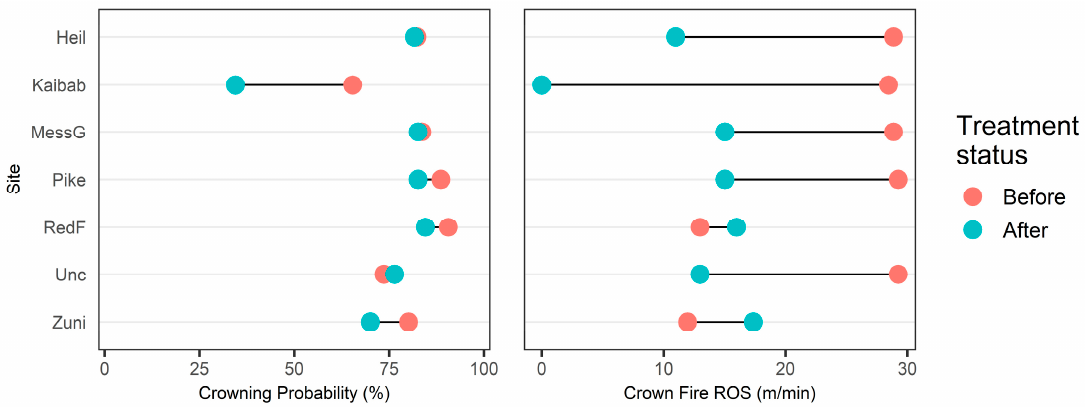
Figure 2. Probability of crowning and predicted crown fire rate of spread (ROS) predicted using the Crown Fire Initiation and Spread model in the firebehavioR package.